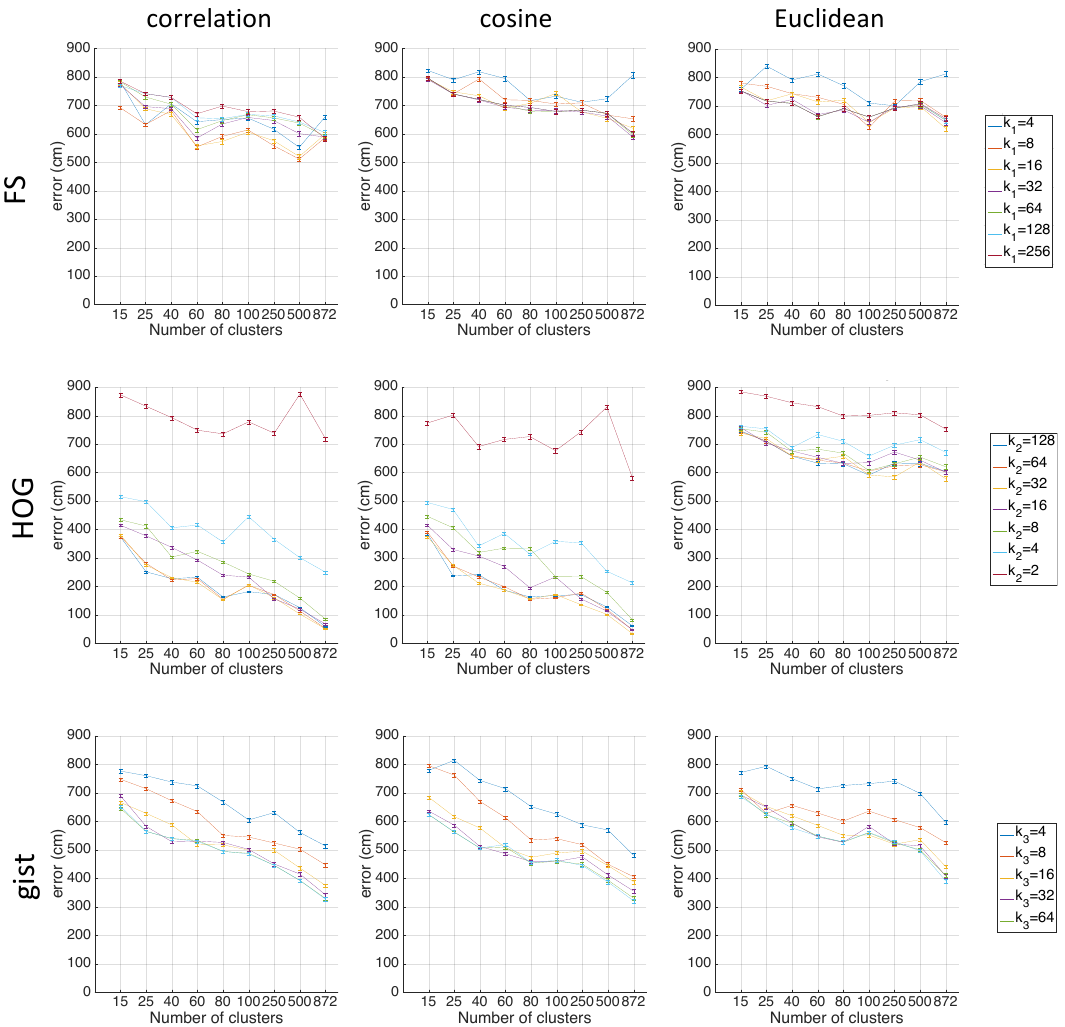
Figure 16. Results of the localization process with FS, HOG, and gist used to describe the representatives of the clusters and the test images: average localization error (cm) vs. number of clusters.